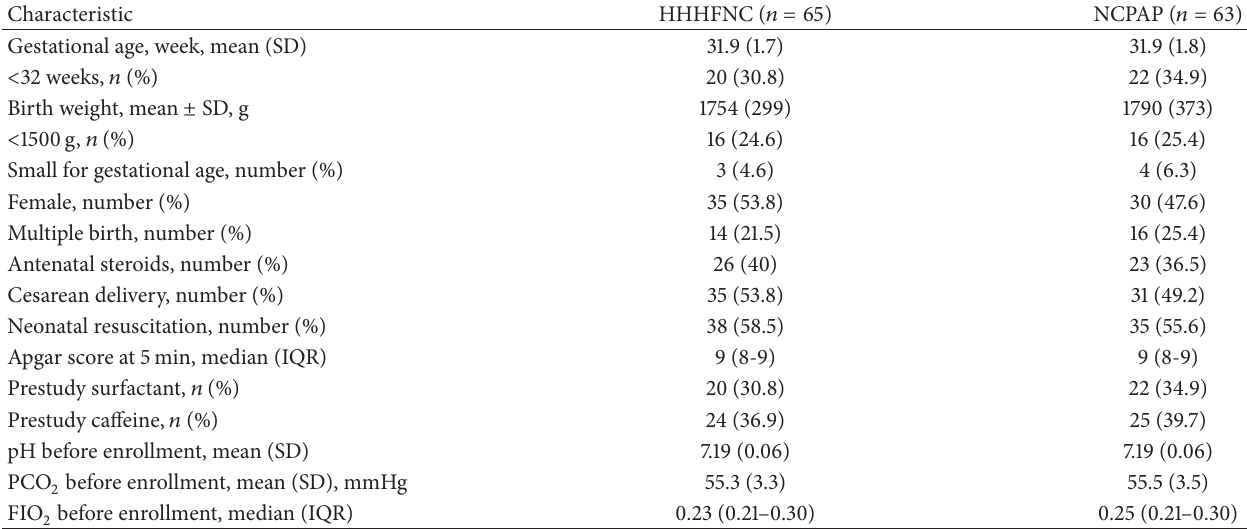
Table 1: Demographic characteristics of the study population.